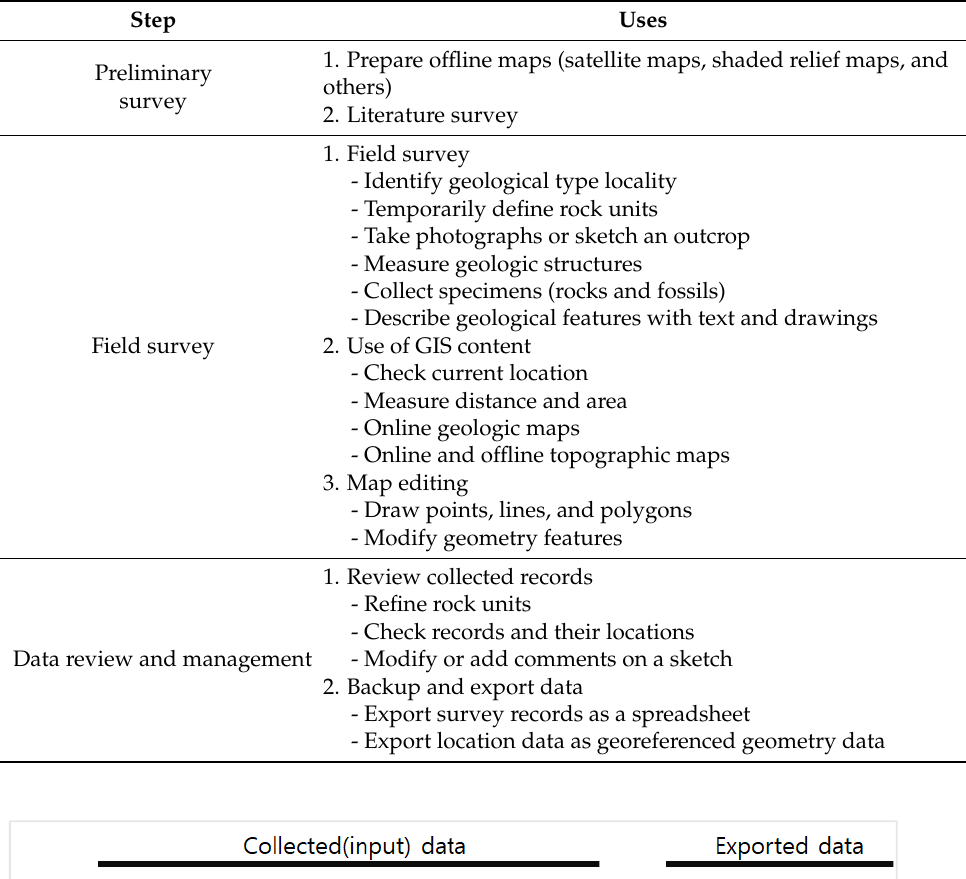
Table 2. Requirements of each system usage step.